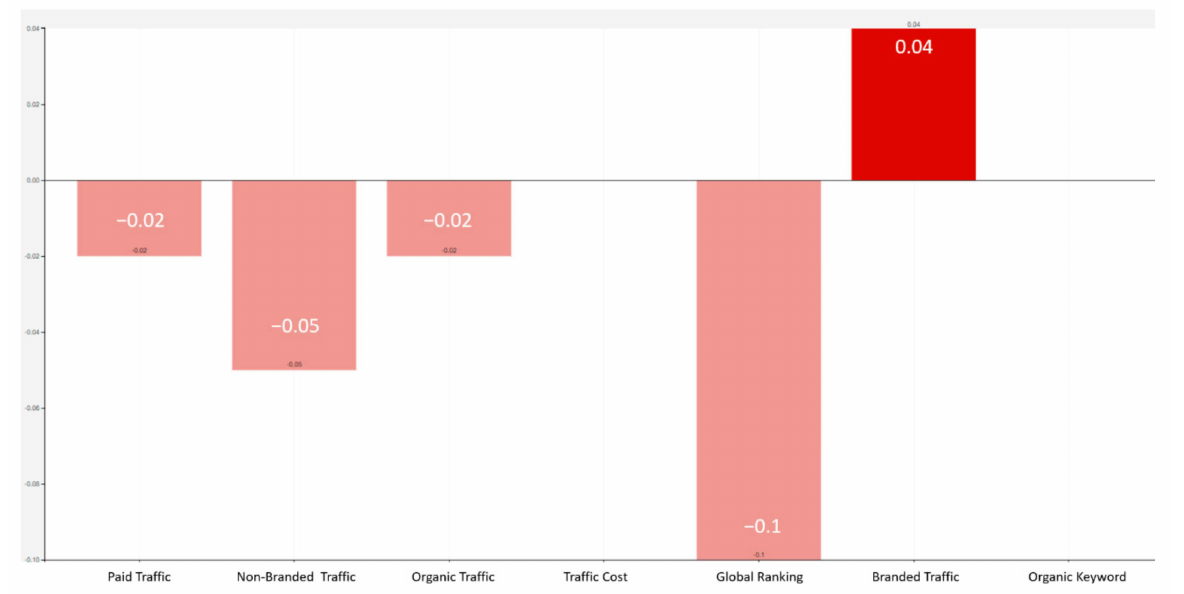
Figure 7. Scenario 2 results (COVID-19 cases at 0.9, paid keywords at